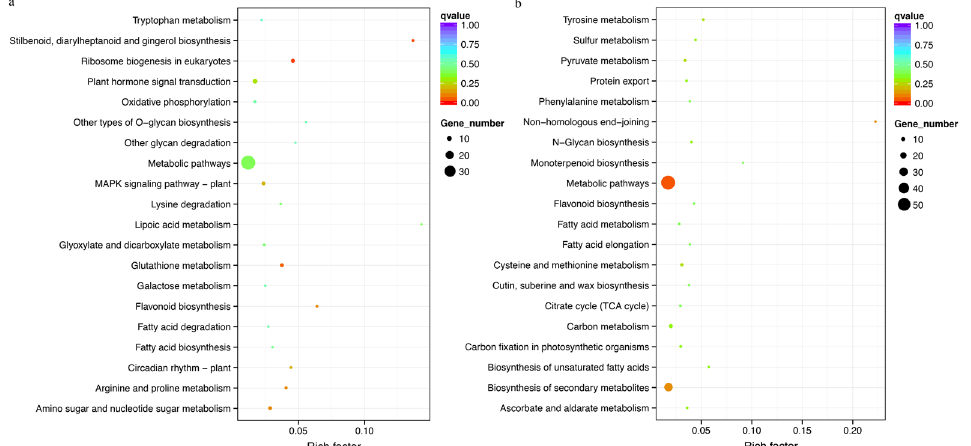
Figure 5. The KEGG enrichment analysis of genes located in the selective sweep regions of two kinds of leaf ball shape B. oleracea accessions. ( a ) The enrichment analysis of genes located in the selective sweep regions in the “Yuanqiu” shape. ( b ) The enrichment analysis of genes located in the selective sweep regions in the “Bianqiu” shape.